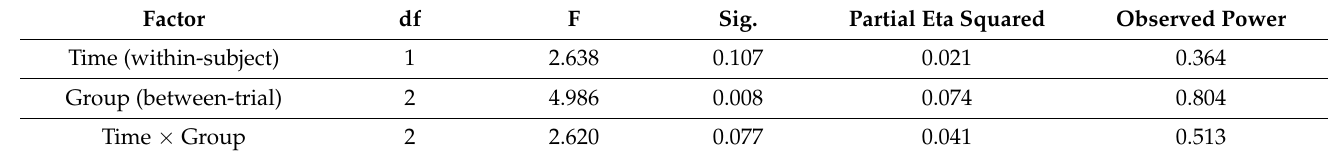
Table 4. Repeated-measures ANOVA results for testosterone